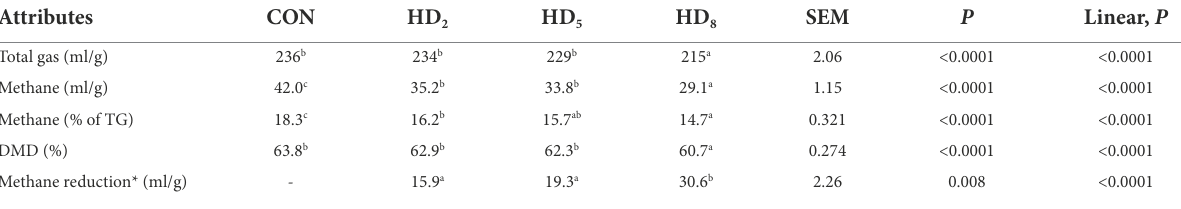
TABLE 2 Effect of anti-methanogenic supplement on in vitro gas production and DMD.